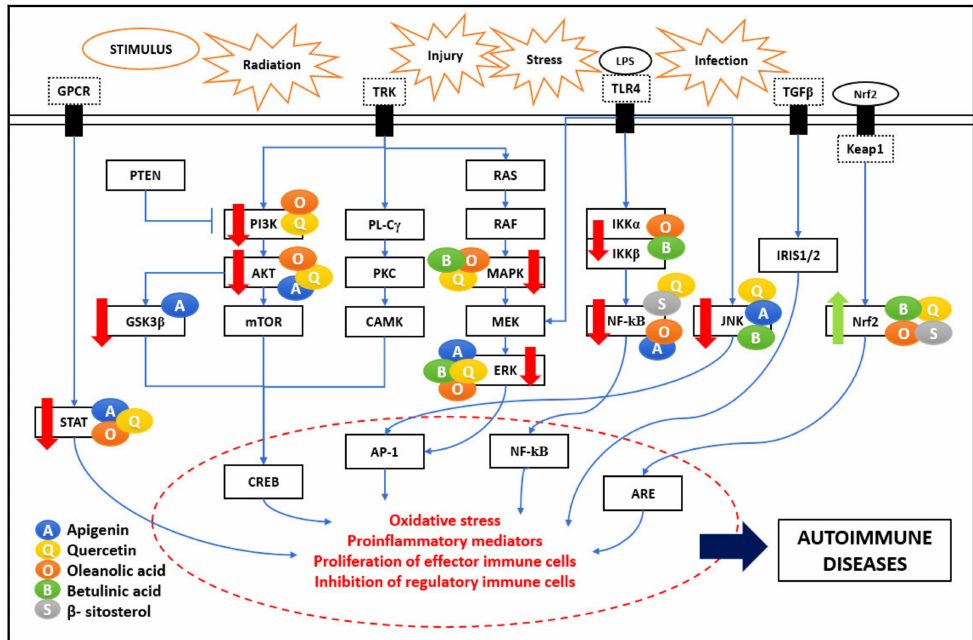
Figure 6. Autoimmune pathogenesis network. The five bioactive compounds detailed in this review show a range of immunomodulatory activities. They impact significant pathways such as NF- κ B, MAPK, PI3K/AKT/mTOR, JAK-STAT, PKC, and Nrf2, regulating oxidative stress and inflammatory mediators. These bioactive compounds are shown as coloured circles and are indicated alongside their respective molecular targets (Blue: Apigenin, Yellow: Quercetin, Orange: Oleanolic acid, Green: Betulinic acid, Grey: β -Sitosterol). The bold red arrows indicate the downregulation of respective pathways, and bold green arrows indicate the upregulation of the particular pathway. The entities of bold square boxes represent different signaling molecules/complexes. The entities of dotted square boxes represent different receptors for signaling pathways. The entities of circle boxes represent the inducers/activators of the particular pathways. The entities in star-shaped boxes represent different stimulus/inducers for signaling pathways. → represents direct activation and (cid:97) represents